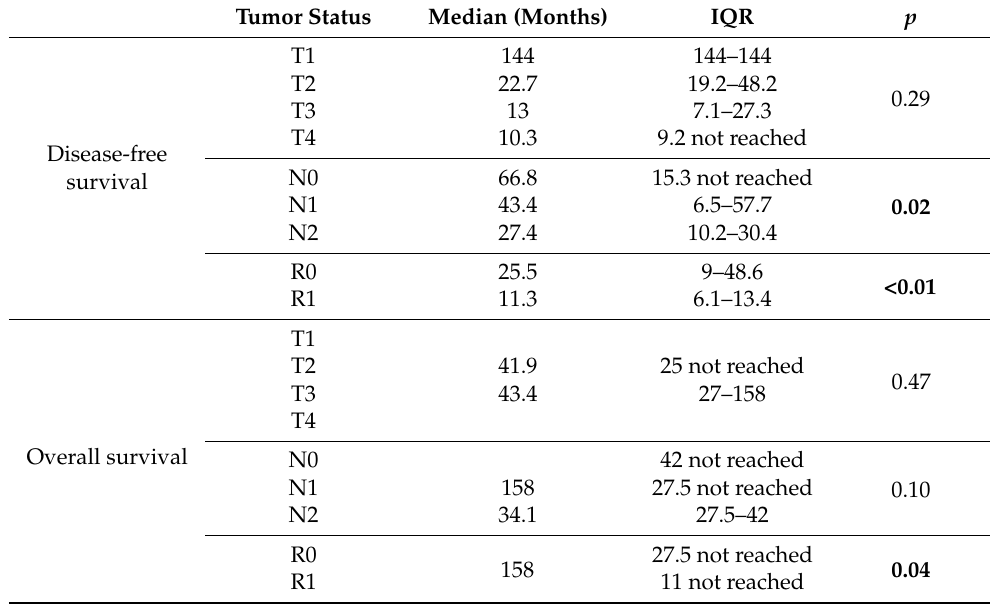
Table 3. Log-rank test estimates of disease-free survival and overall survival according to tumor status.